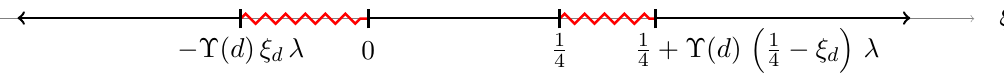
Figure 4 . The ANEC bounds exclude two ranges of ξ , in red zig-zag lines, below ξ = 0 and above ξ = 1 / 4 when 3 < d < 4